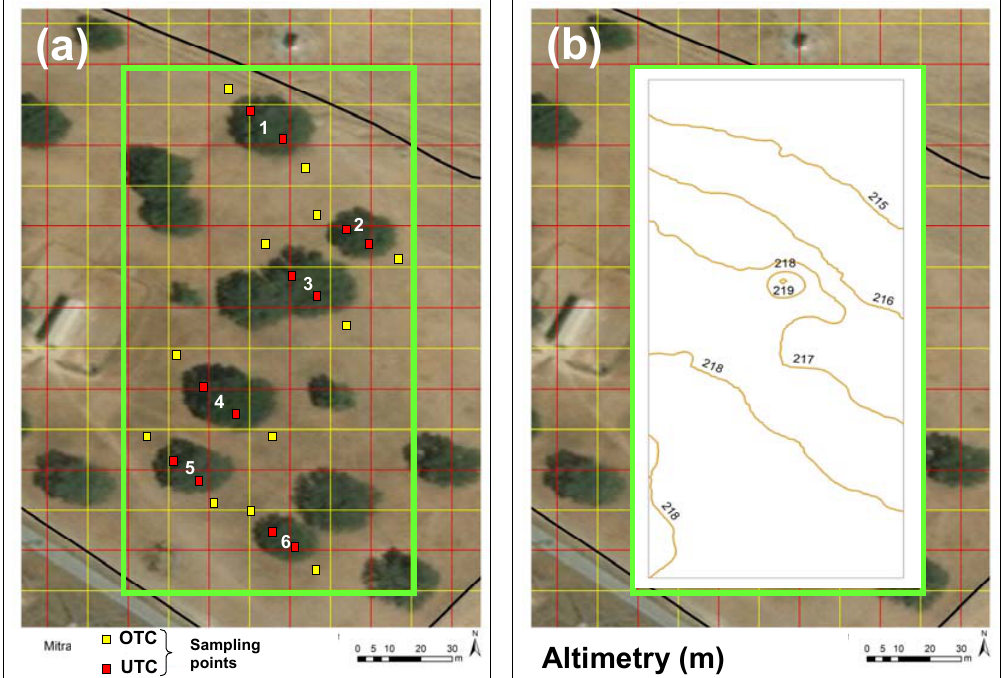
Figure 2. ( a ) Location of trees (six) and sampling points (12 under tree canopy—UTC; 12 outside tree canopy—OTC) and ( b ) altimetric map of experimental field.